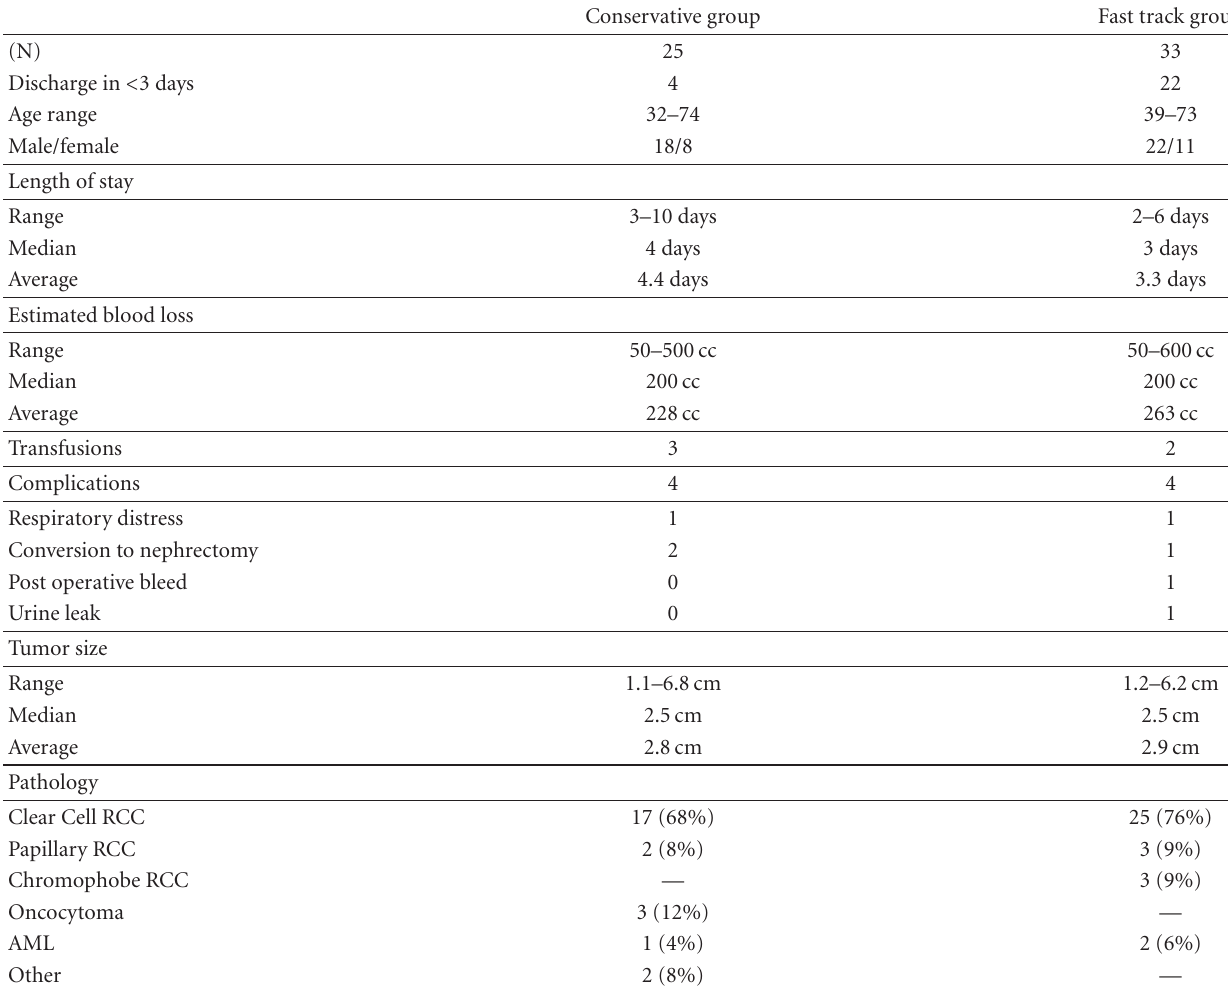
Table 2: Outcomes of fast track open partial